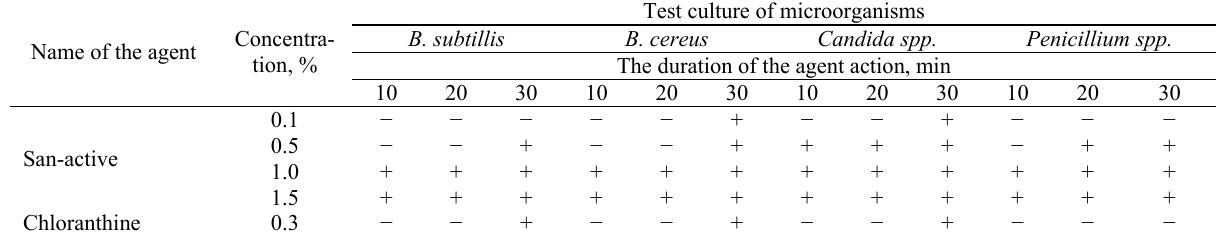
Influence of “San-active” on spore-forming and fungal microflora in the suspension method, n = 36